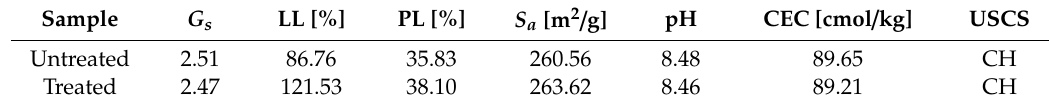
Table 2. Index properties of the tested clays.